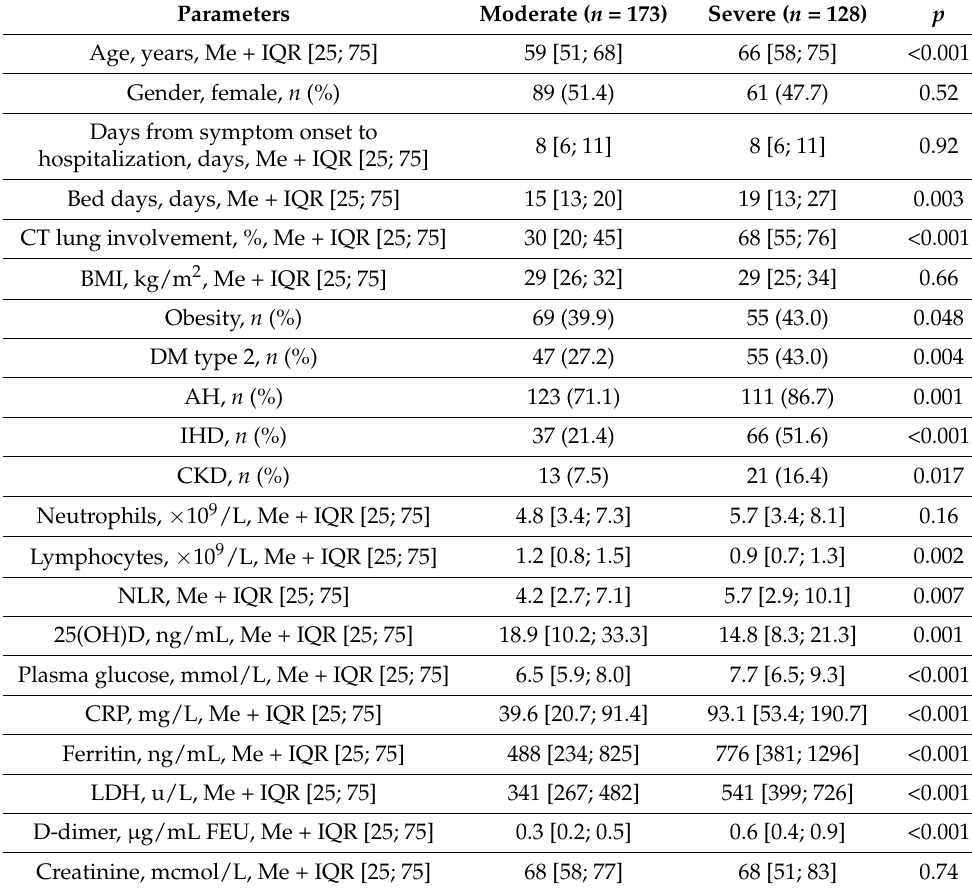
Table 1. Patients’ baseline characteristics depending on COVID-19